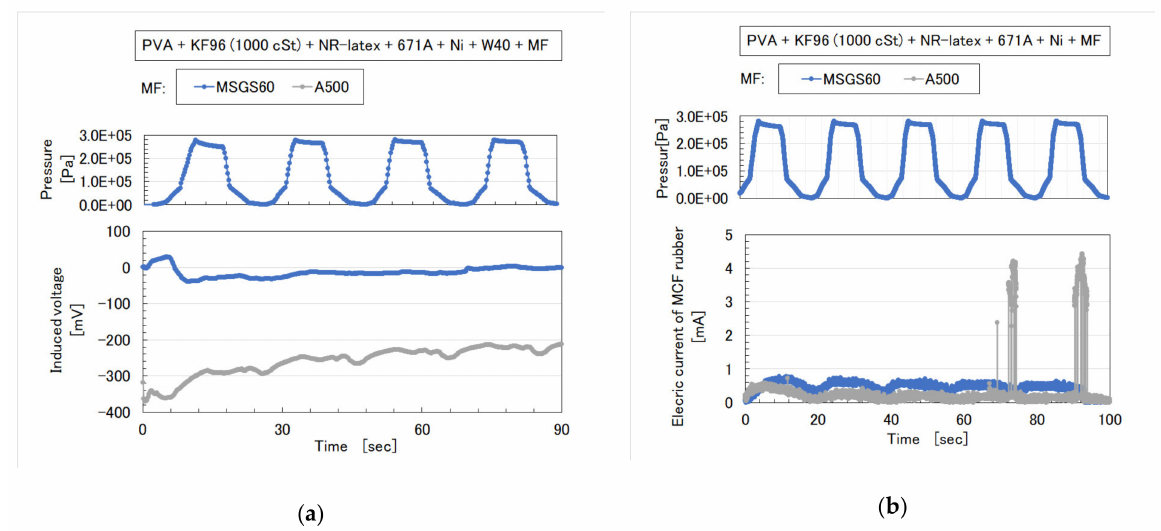
Figure 15. Induced voltage and electric current as piezo-resistivity of MCF rubber with KF96, water-insoluble MF, and water-based MF to repeat application of pressure in Figure 7: ( a ) piezo-electricity; ( b )